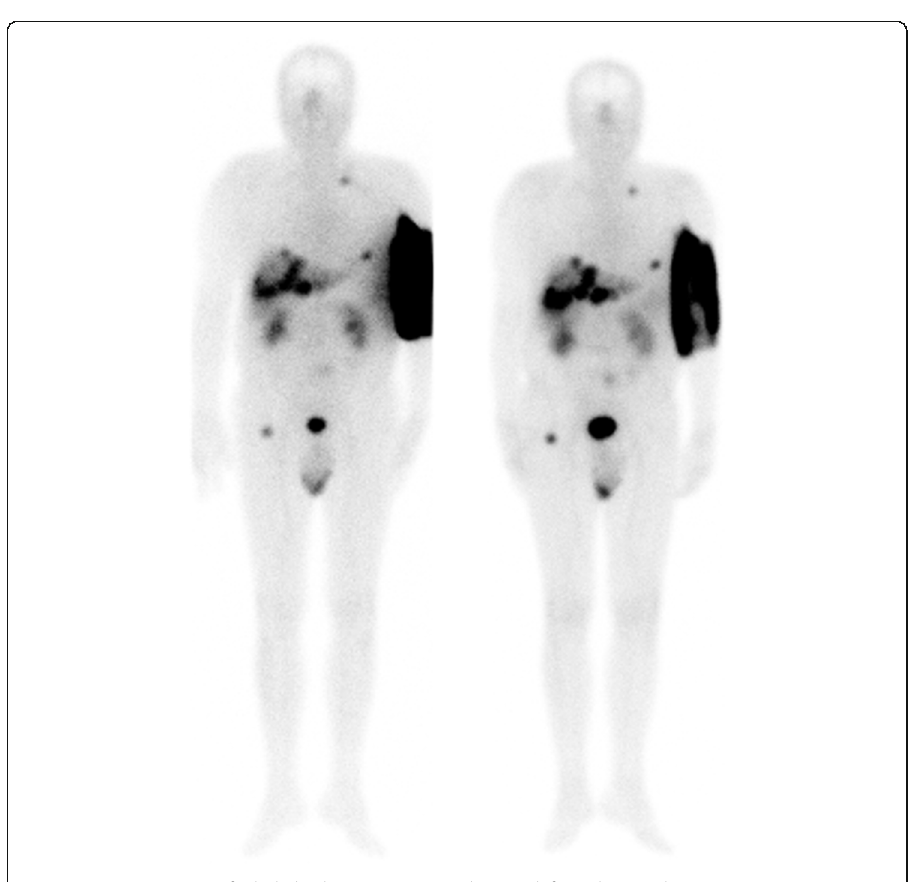
Fig. 5 Geometric mean of whole body images acquired at T 2h (left) and T 5h